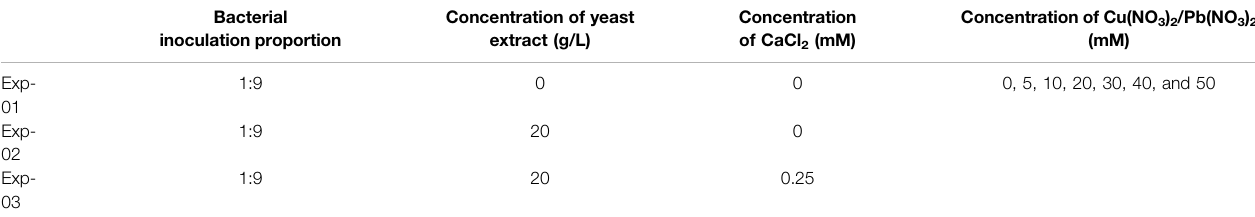
TABLE 1 | Scheme applied to the test tube experiments.